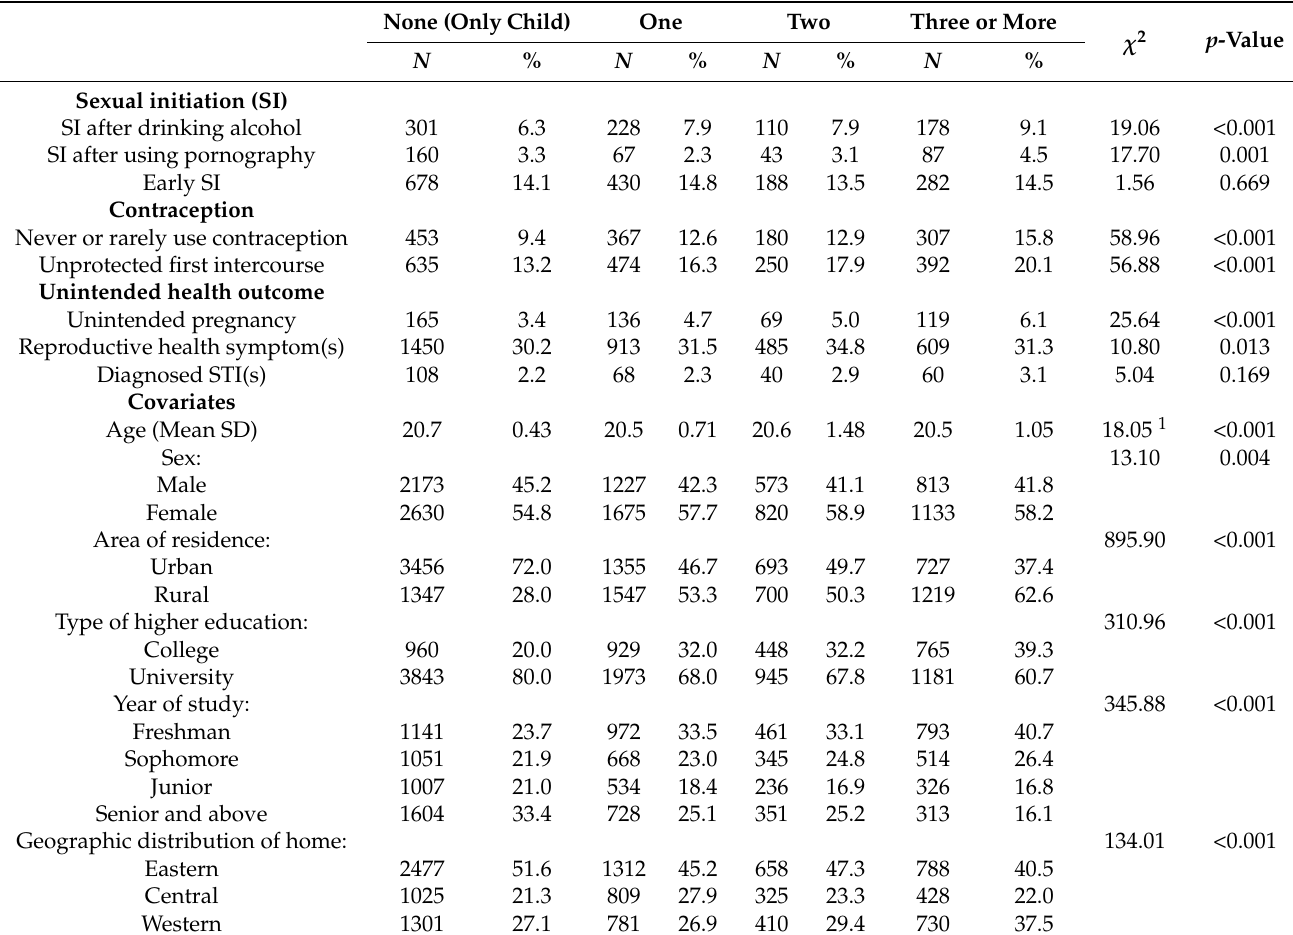
Table 1. Characteristics of study participants by the number of